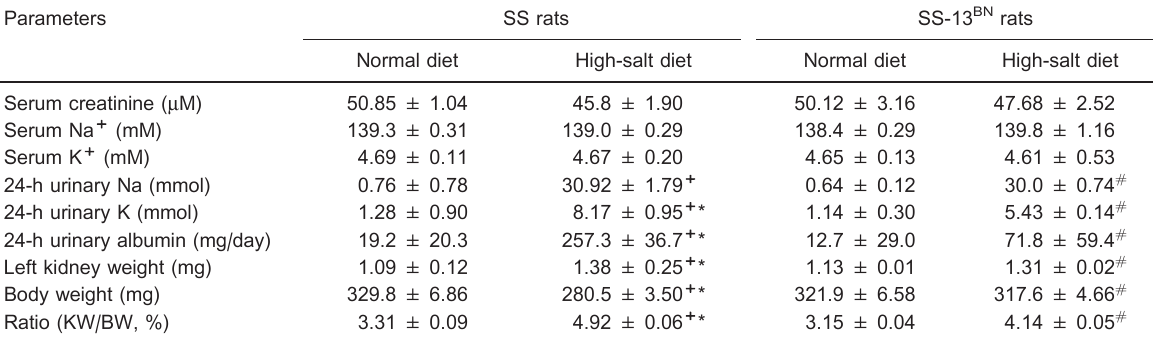
Table 2. Biochemical parameters of blood and urine and body and kidney weights of all groups. Parameters